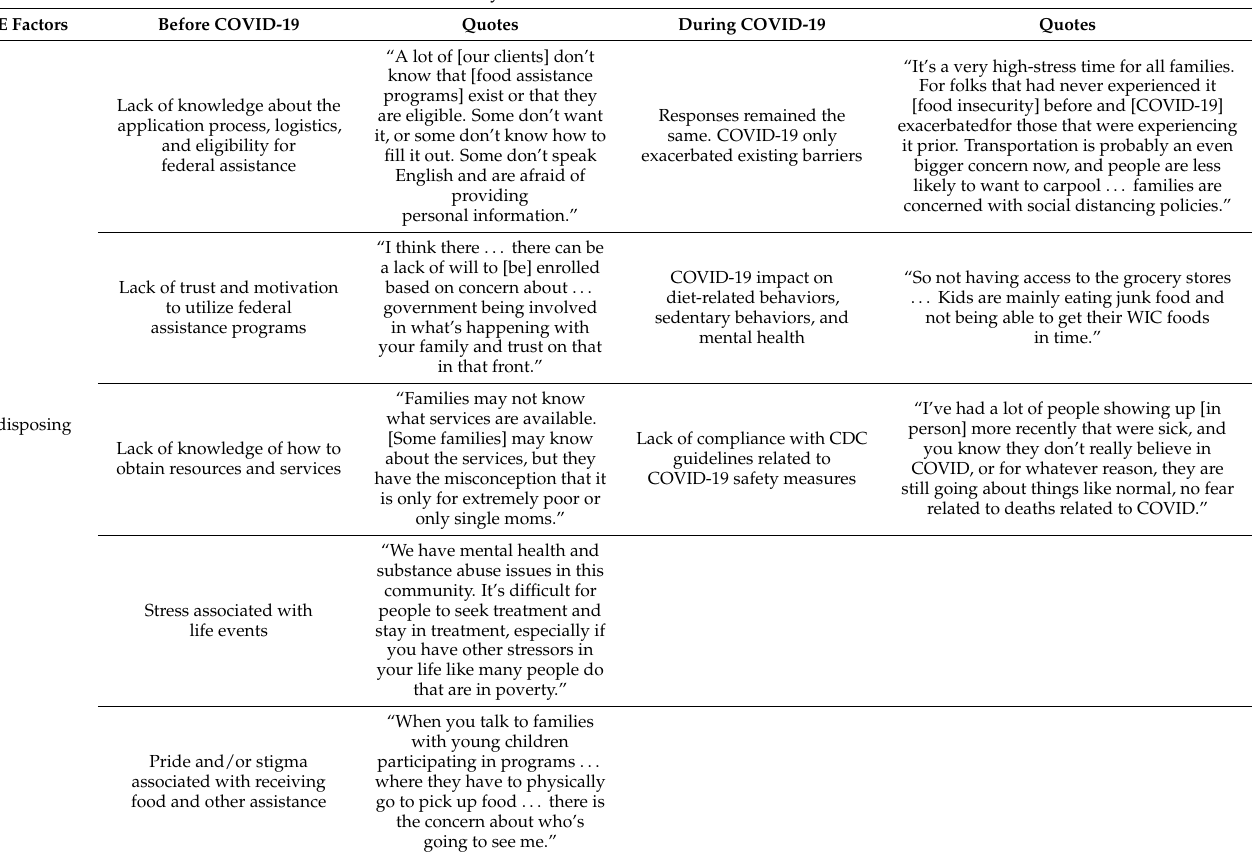
Table 2. Predisposing, Reinforcing, and Enabling (PRE) factors influencing the barriers to obtaining adequate, high-quality, and age-appropriate food for children under three in low-income communities before and during